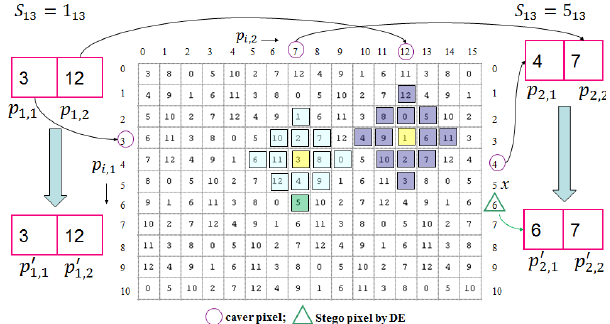
Figure 2. Illustration of Diamond encoding